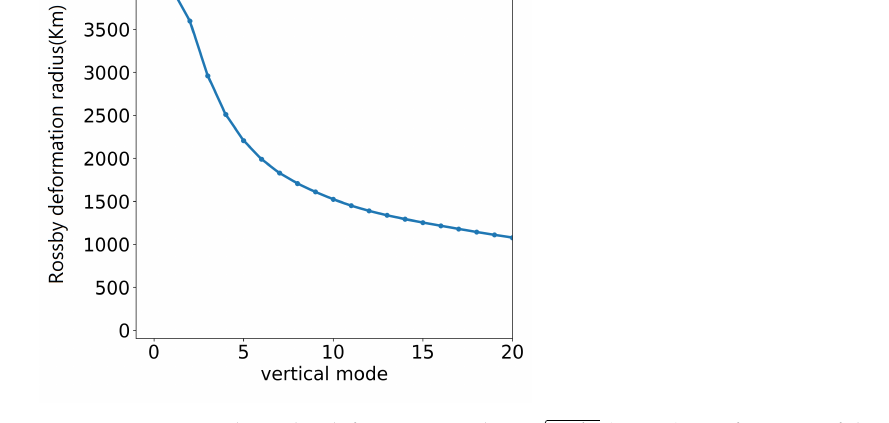
Figure 2. Equatorial Rossby deformation radius index m